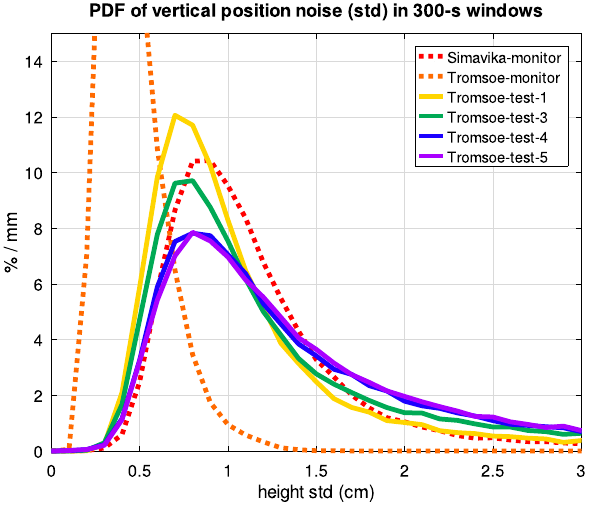
Fig. 11 Median and 95th percentile of absolute vertical position error as a function of distance to the nearest network receiver, for magnetic day-time (top panel) and magnetic night-time (bottom panel). The dashed lines are linear fits, with the fitted parameters reported in the legend